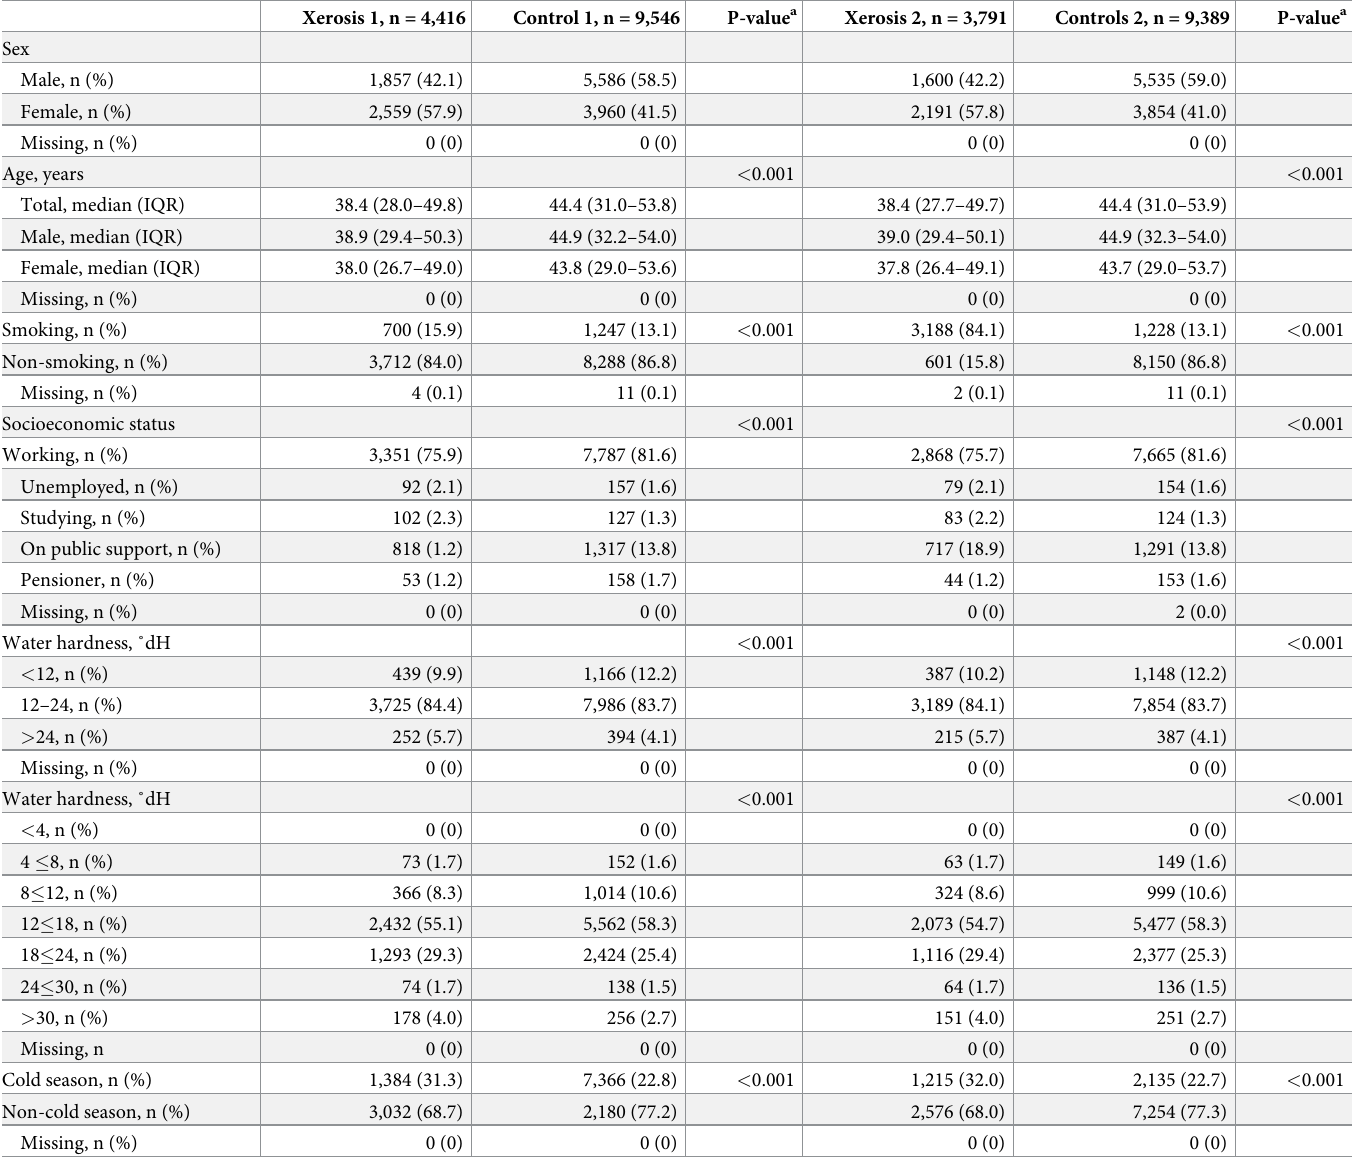
Table 1. Demographics of blood donors with xerosis and